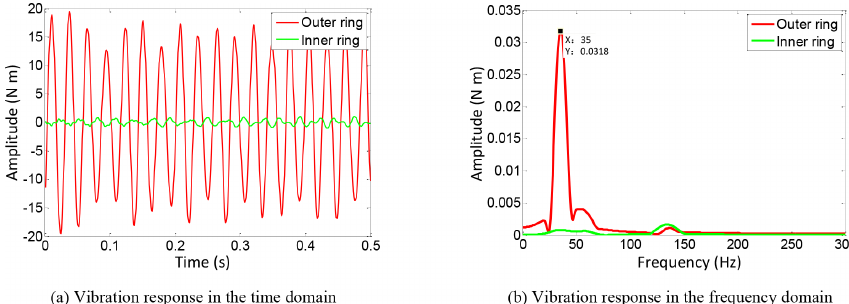
Figure 9. Vibration responses of the outer ring and inner ring.